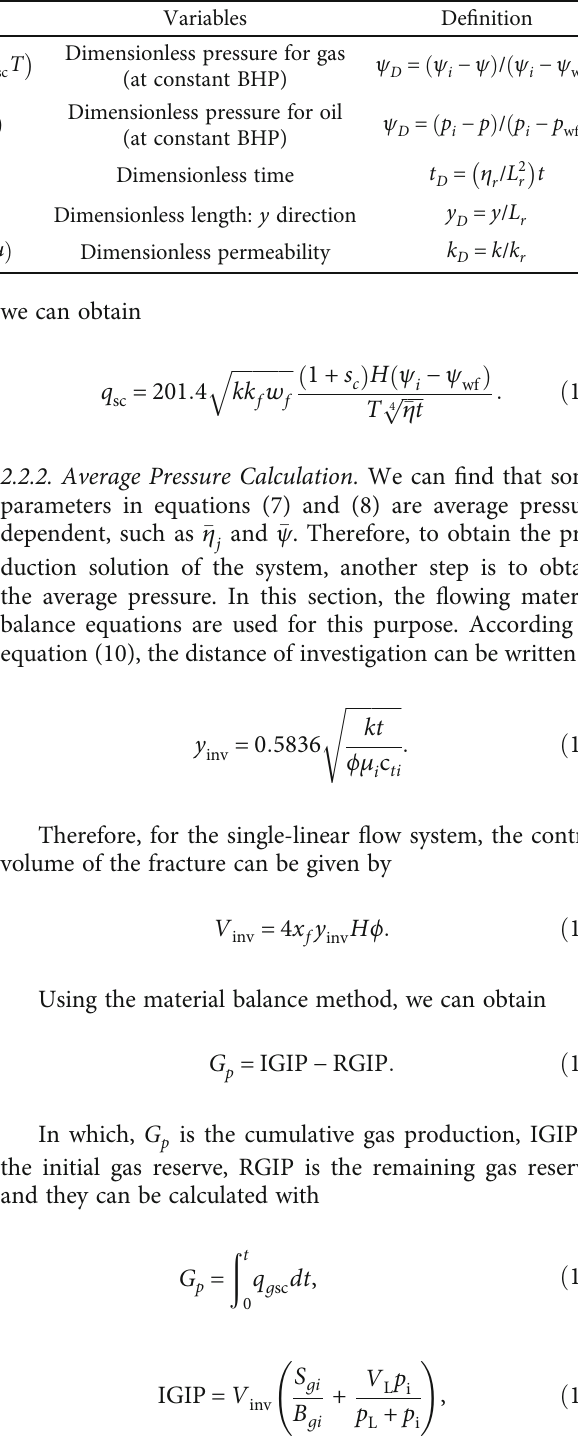
Table 1: De fi nitions of the dimensionless parameters used in the model